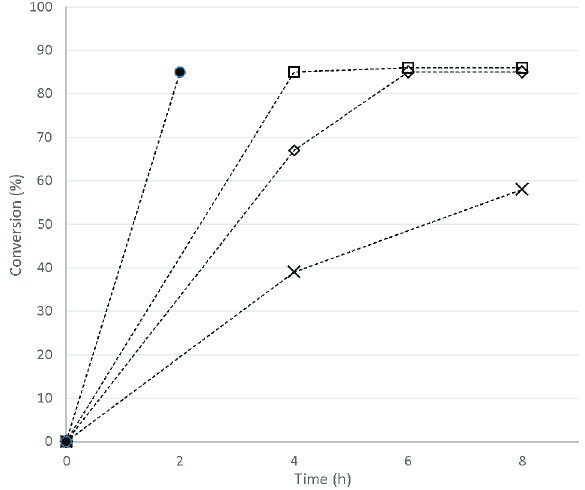
Figure 2. Conversion of substrate as function of time (h) and catalyst HBF 4 ( ● ) or MoCl 2 O 2 (1 mol % (×), 2 mol % ( ◊ ), 3 mol % ( □ )) in the methanolysis of